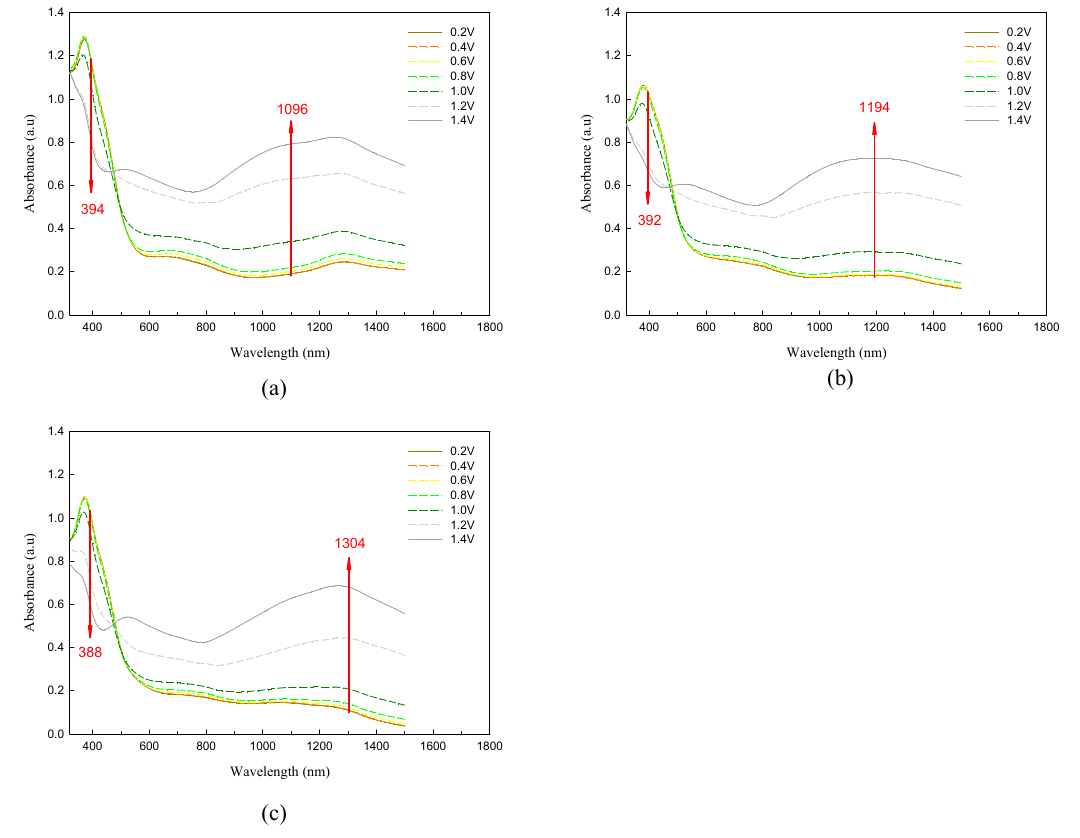
Figure 6. Spectroelectrochemical spectra of P(TTPA- co -BDTA) films on ITO electrode as applied potentials between 0.2 V and 1.4 V in an ionic liquid solution. The copolymer films were prepared potentiostatically at: ( a ) 1.0 V; ( b ) 1.1 V; and ( c ) 1.2 V on ITO glass electrodes. Table 2. Electrochromic photographs and colorimetric values (L*, a*, b*) of the copolymer films at various potentials in ionic liquid solution. E /V Photographs